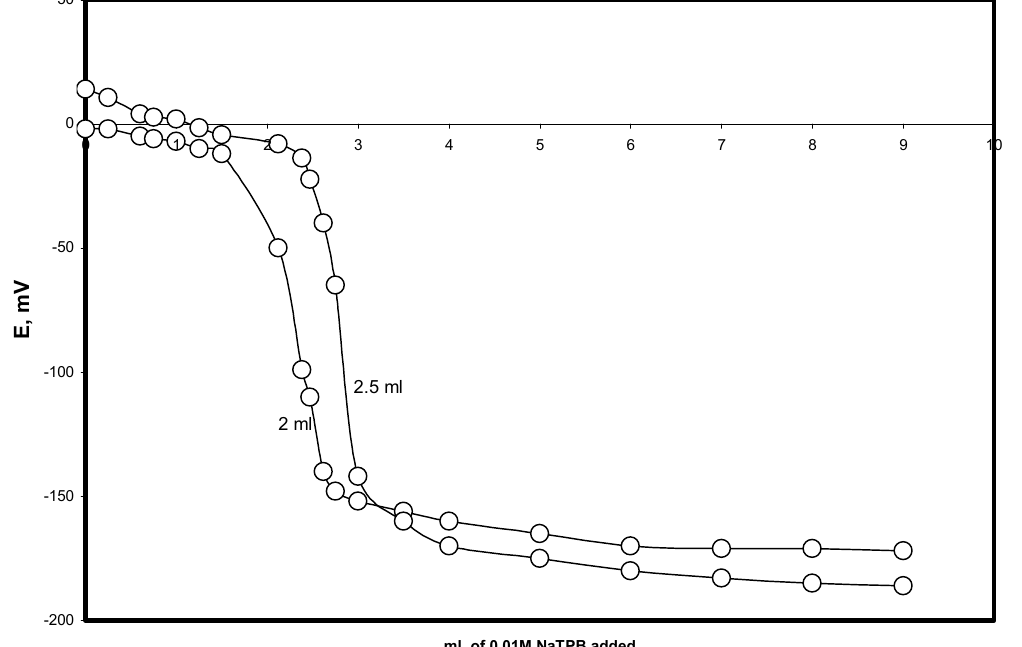
Figure 3.b. Typical potentiometric titration curves of 2 and 2.5 ml of 1 × 10 -2 M of AC with 1 × 10 - 2 M sodium tetraphenylborate using AC-PM membrane